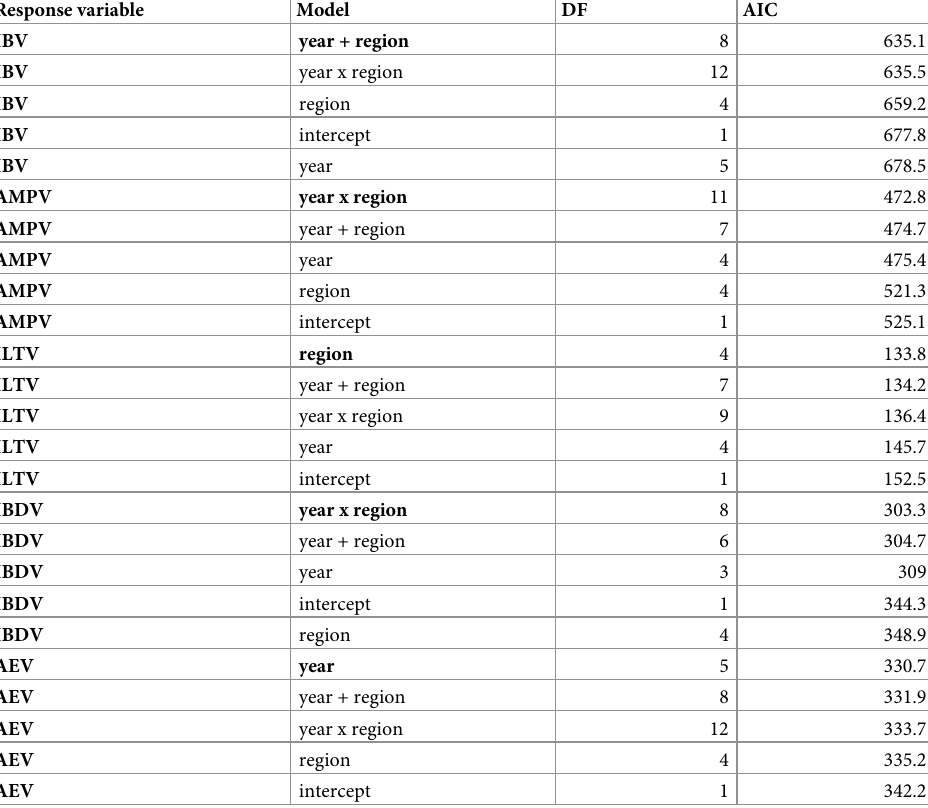
Table 1. Comparison of all candidate models for each of the five antibody prevalences. Response variable